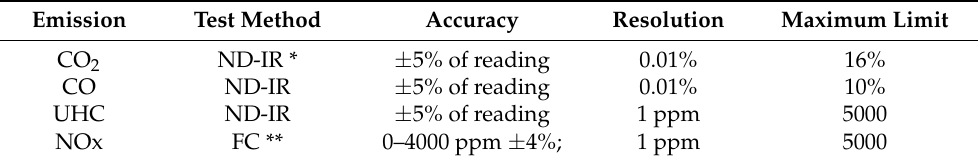
Table 3. Gas analyzer technical